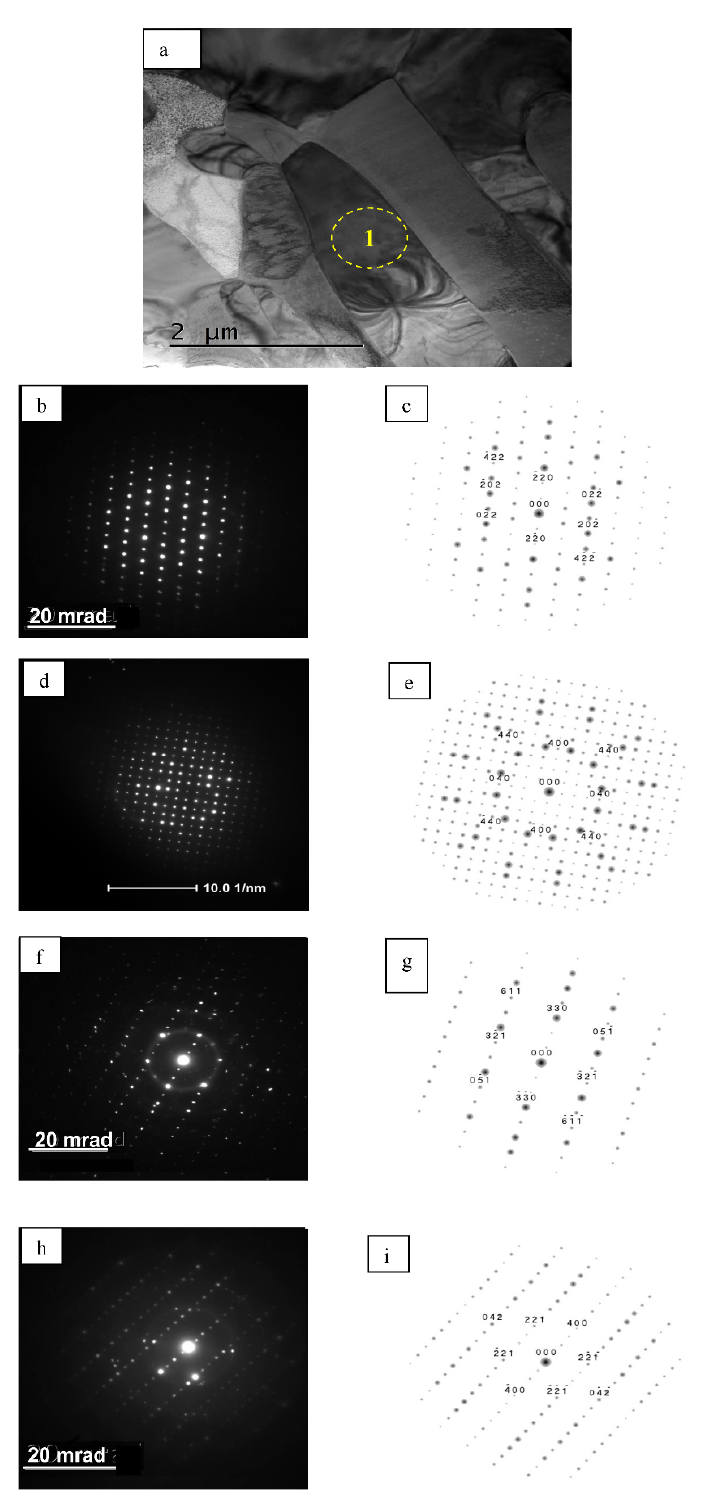
Figure 4. TEM image of cross-section of precipitates in the interdiffusion layer ( a ); and a series of electron diffractions taken at different tilt angles ( b , d , f , h ) with their solutions ( c , e , g , i ), respectively. Platinum dissolved in the β -NiAl phase in the additive and interdiffusion layers. Hafnium was present there only in the form of Hf-rich precipitates of size from ~0.5 to ~1 µ m located mainly in at